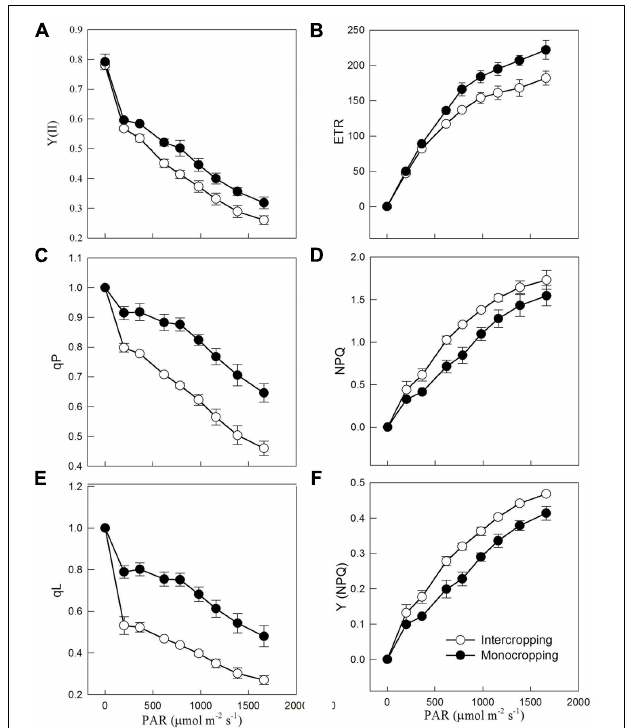
FIGURE 3 | Chlorophyll a fluorescence parameters derived from the rapid light curves in monocropping and intercropping. (A) Y(II), the photochemical efficiency of PSII, (B) ETR, electron transport rate, (C) qP, coefficients estimating the fraction of open PS II reaction centers based on a puddle model, (D) NPQ, non-photochemical quenching, (E) qL, coefficients estimating the fraction of open PS II reaction centers based on a lake model, and (F) Y(NPQ), quantum yield of non-photochemical quenching.